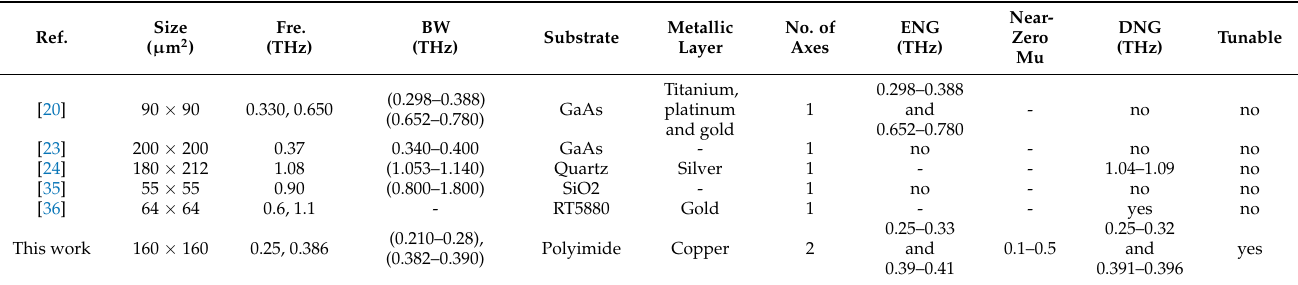
Table 5. Proposed MTM comparison with the reported state of the